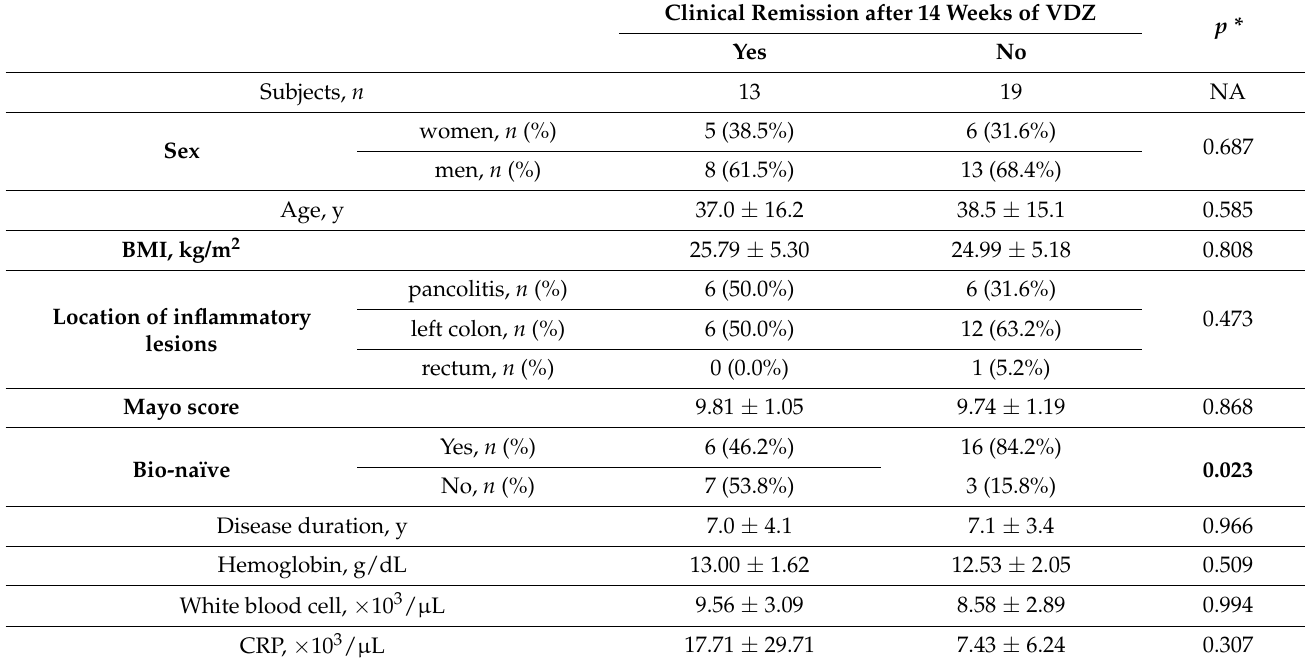
Table 1. Baseline clinical characteristics in the ulcerative colitis (UC) patients with and without achievement of clinical remission after 14 weeks of vedolizumab induction